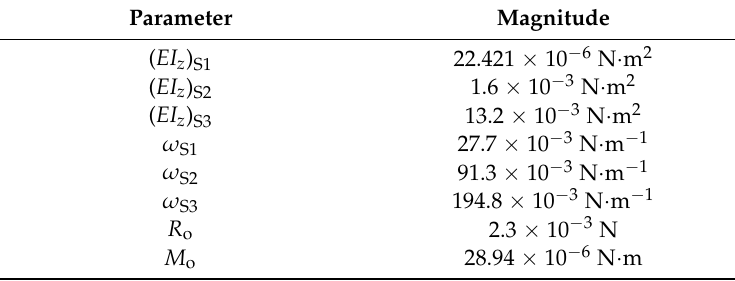
for the pVEH microdevice.